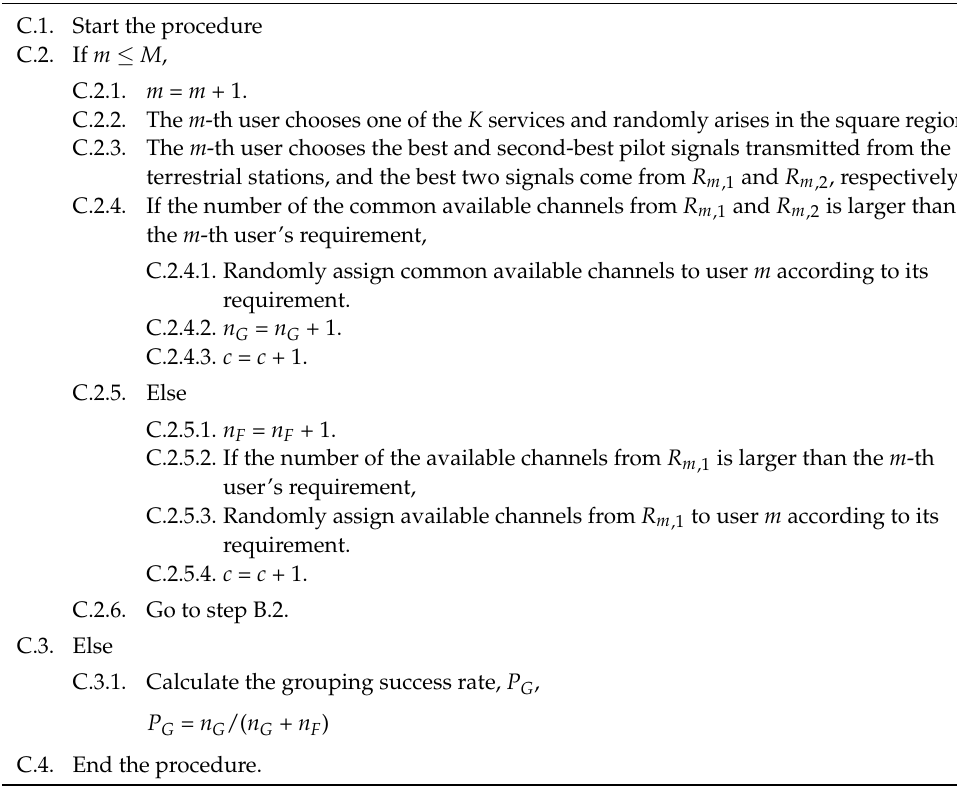
Algorithm 5: Single relay allowed grouping applying in multi-services